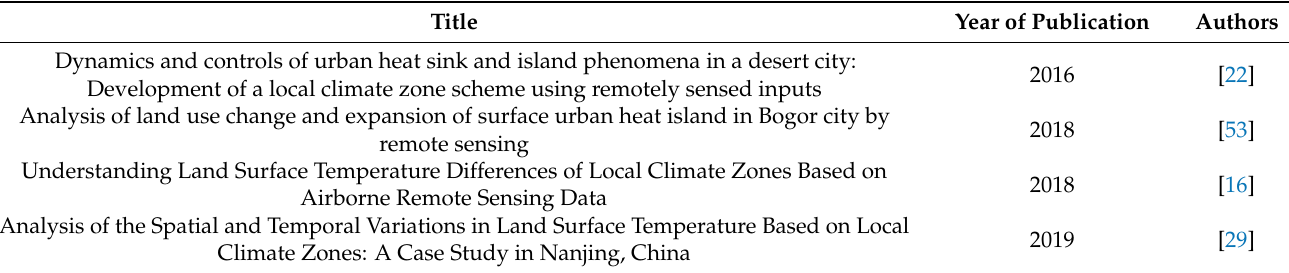
Table A1. Articles read in the systematic review in chronological order of